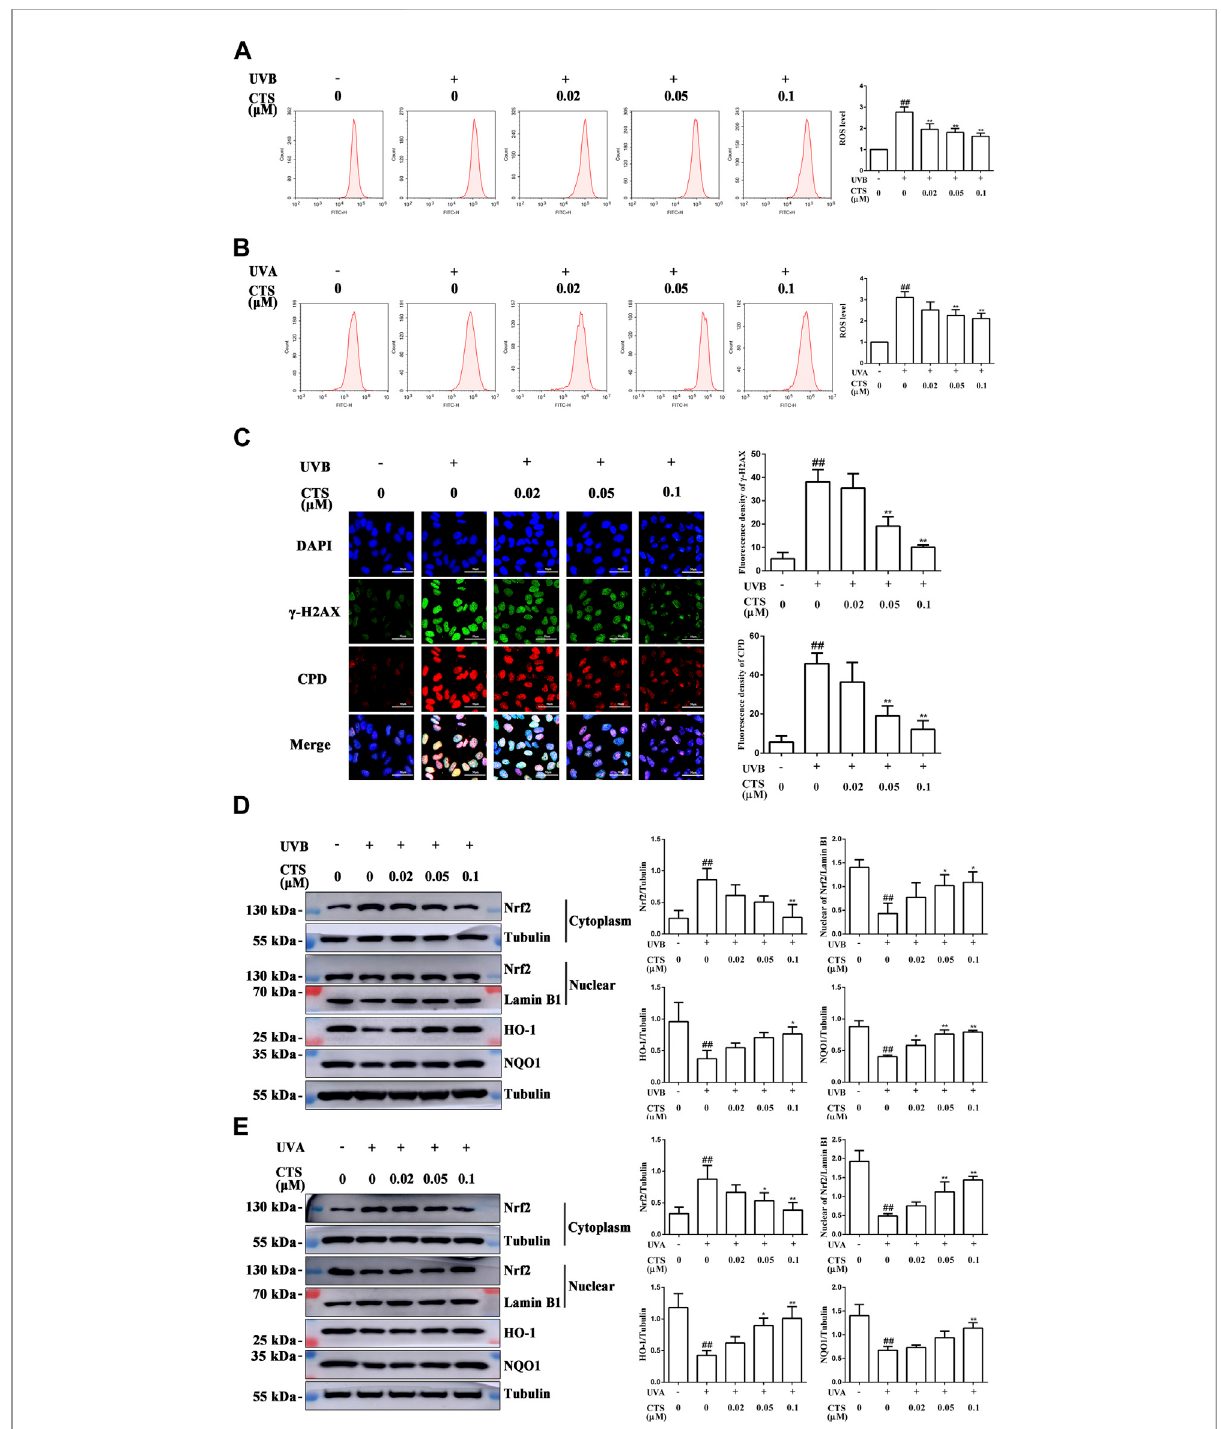
FIGURE 2 Effects ofCTSon UVradiation-in fl icted oxidative damage inHaCaTcellsand HFF-1 cells. HaCaTcells andHFF-1 cellsweretreated withCTS (0, 0.02, 0.05, 0.1 μ M) for 4 h prior to UVB (200 mJ/cm 2 ) and UVA (15 J/cm 2 ) irradiation, respectively. After UV irradiation, the cells were supplemented withthecorrespondingdosesofCTSandincubatedfordifferenttimesbeforeanalysis. (A) FlowcytometryanalysisofROSproductionbyHaCaTcells. TheplotquantitativelycomparesthelevelsofROSforthedifferentCTSconcentrations. (B) FlowcytometryanalysisofROSproductionbyHFF- 1cells.TheplotquantitativelycomparesthelevelsofROSforthedifferentCTSconcentrations. (C) Immuno fl uorescencestainingofCPDand γ -H2AX proteins in HaCaT cells after 2-h of incubation following UVB irradiation. Red fl uorescence represents CPD, whereas green fl uorescence represents γ -H2AX. All cells were counterstained with DAPI (blue). Scale bars: 50 μ m. The plot besides the fl uorescence image counts the number of